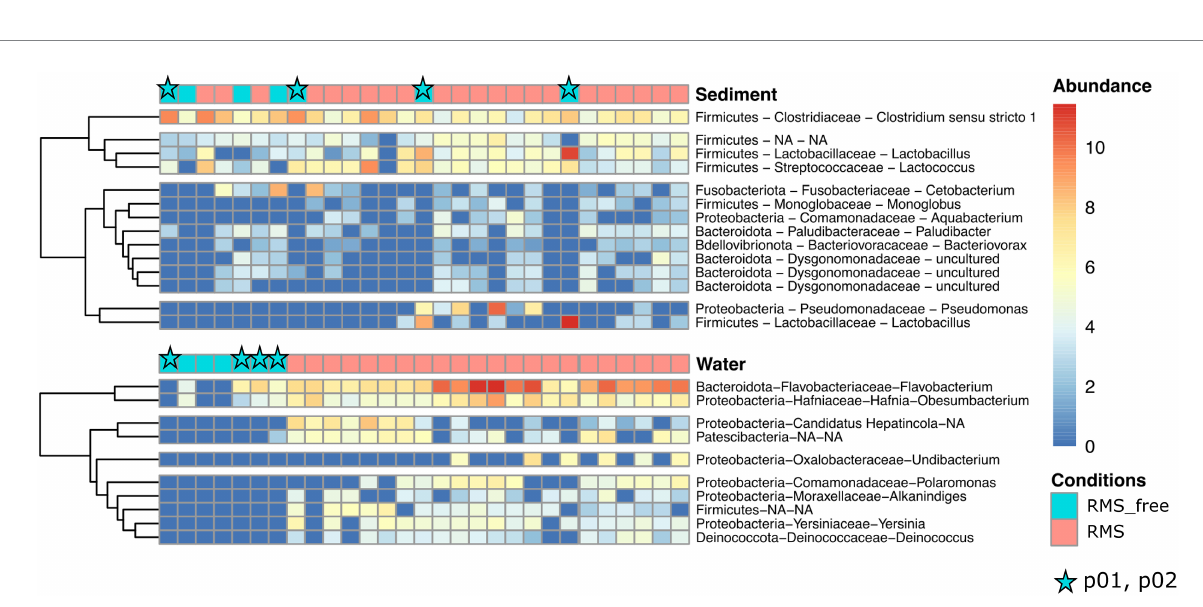
FIGURE 6 Heatmaps showing the relative abundances of ASVs, assigned at the taxonomic rank of Genus, for water and sediment samples, comparing the conditions RMS vs. RMS-free. Abundances are expressed as log2 of fold change. Stars indicate samples collected in p01 and p02 (no fish